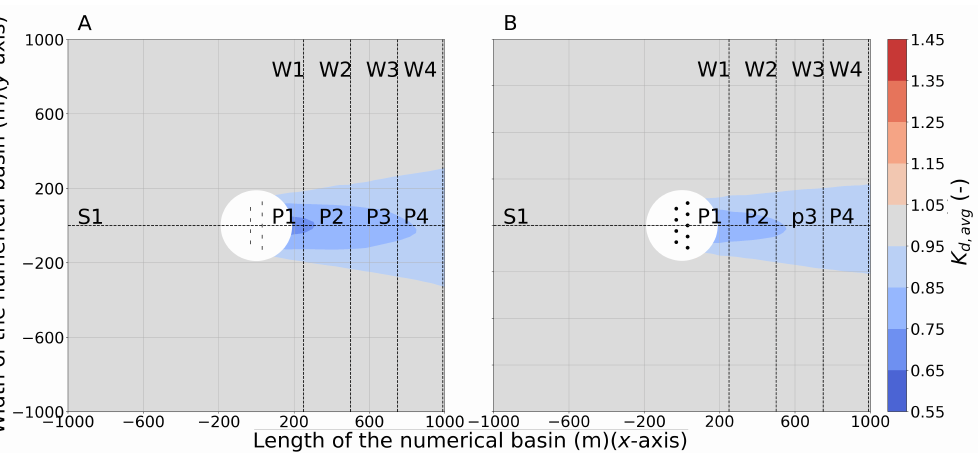
Figure 11. K d disturbance coefficient results for a 9-OSWEC array (O2) ( A ) and a 9-HCWEC array (H2) ( B ) interacting with short-crested irregular wave with H s = 2.0 m, T p = 8.0 s and s 1 = 15.8. The coupling region is filled using a white solid circle which includes the WEC (indicated by black solid circles). Incident waves are generated from the left to the right. S1, W1, W2, W3, and W4 indicate the location of